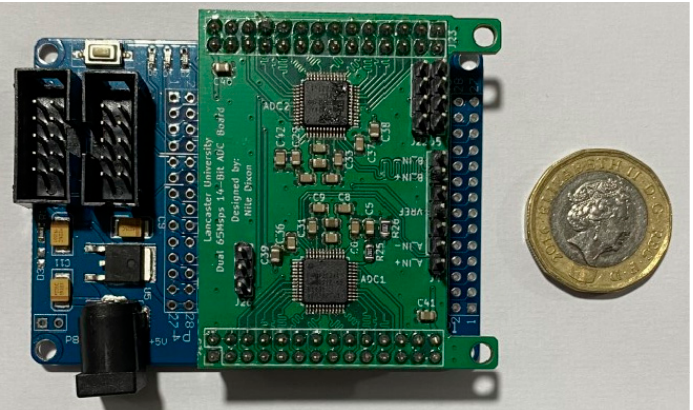
Figure 9. Image of a manufactured ADC board, populated with two AD9244 ADCs and supporting circuitry, sitting on top of the Cyclone II minimal development board. A pound coin is shown for scale.